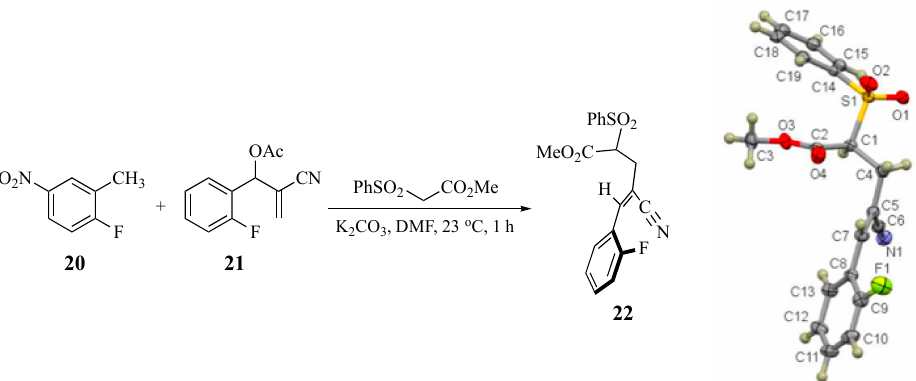
Scheme 2. Control experiment: Selective reaction of the MBH acetate and formation of the Z alkene 22 (CCDC